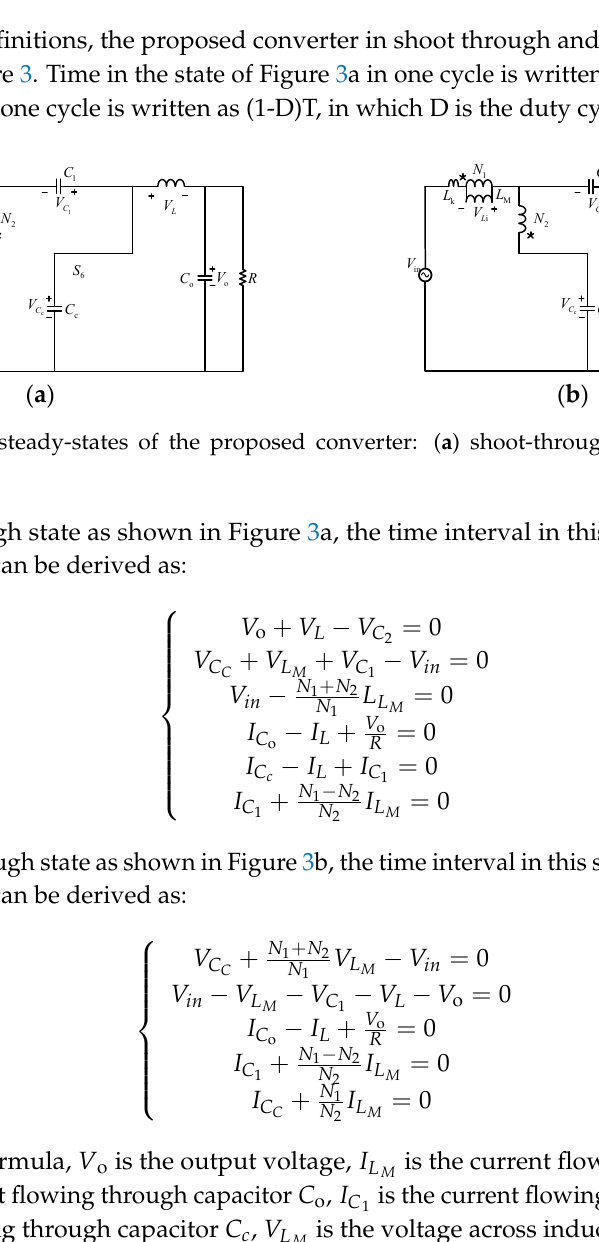
Figure 2. Equivalent circuit of the proposed converter.